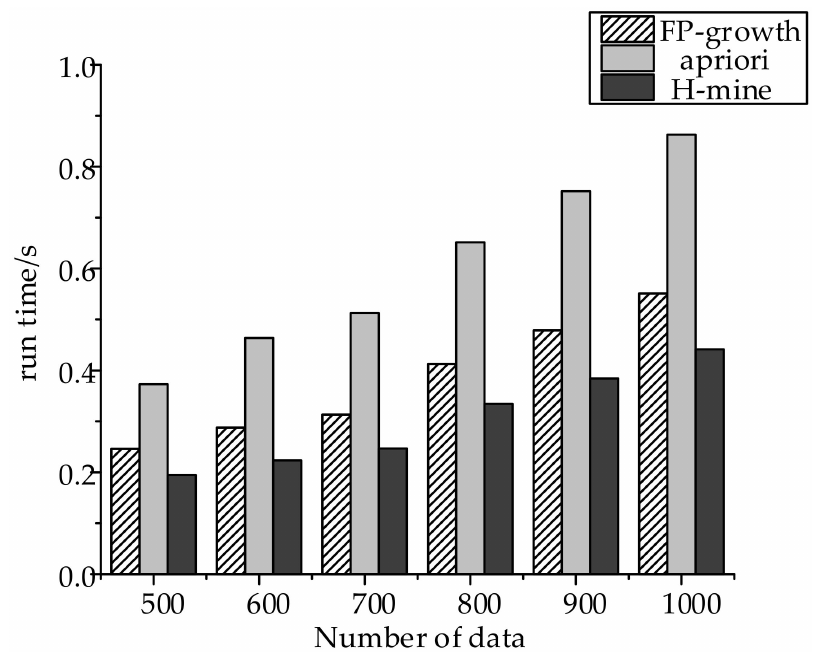
Figure 6. Algorithm performance comparison